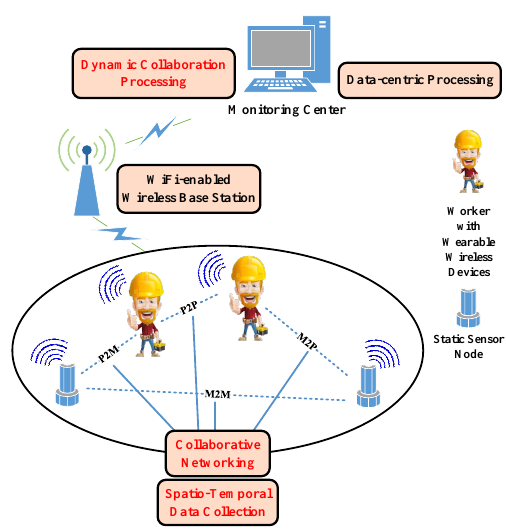
Figure 4. An application scenario of the CSI framework to improve the capability of detecting toxic gases in a large-scale petrochemical plant. This application consists of four components: sensor-embedded wearable wireless devices, static wireless sensor nodes, WiFi-enabled wireless base stations and a remote monitoring centre. The wearable wireless devices are worn by workers and collaborate with static wireless sensor nodes to sense the surrounding environment and collect spatio-temporal data. The data are sent to the remote monitoring centre via WiFi-enabled wireless base stations. In the monitoring centre, based on the collected data, by data-centric dynamic collaboration, the collaborative networking among different wireless devices can be achieved. Such networking constructs a problem-solving network to detect the leakage of toxic gases. Moreover, on such a networking basis, the CSI can be achieved in this scenario.